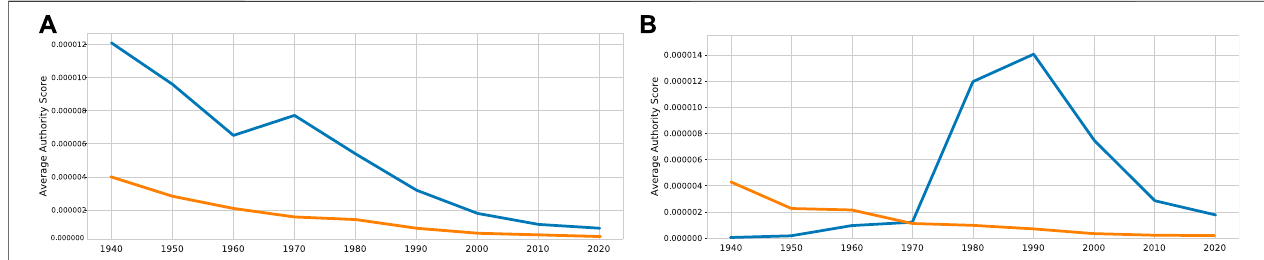
FIGURE 9 | Authority scores of (A) The complete network and (B) the cross-jurisdictional network between 1940 and 2020. For the real networks the authority scores are shown in blue, for the random networks the scores are shown in orange.